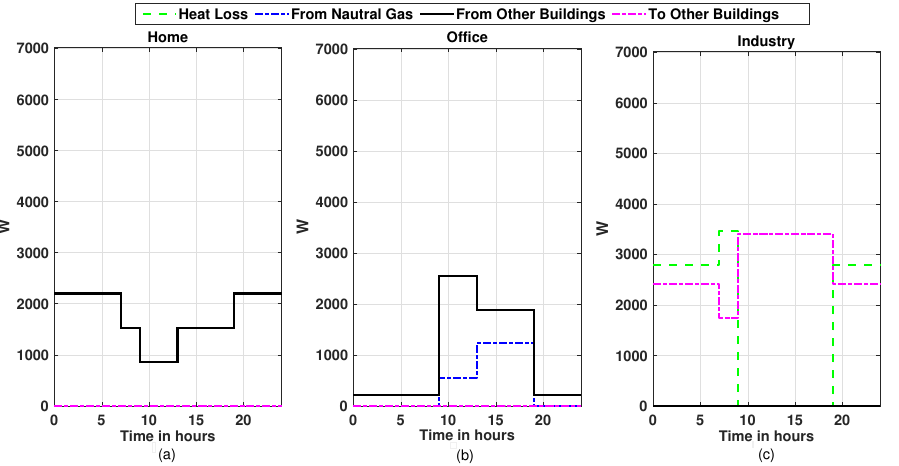
Figure 7. Heating cooperation among the buildings for 24 h in the month of November, ( a ) for the home building, ( b ) for office building, and ( c ) for industry building.